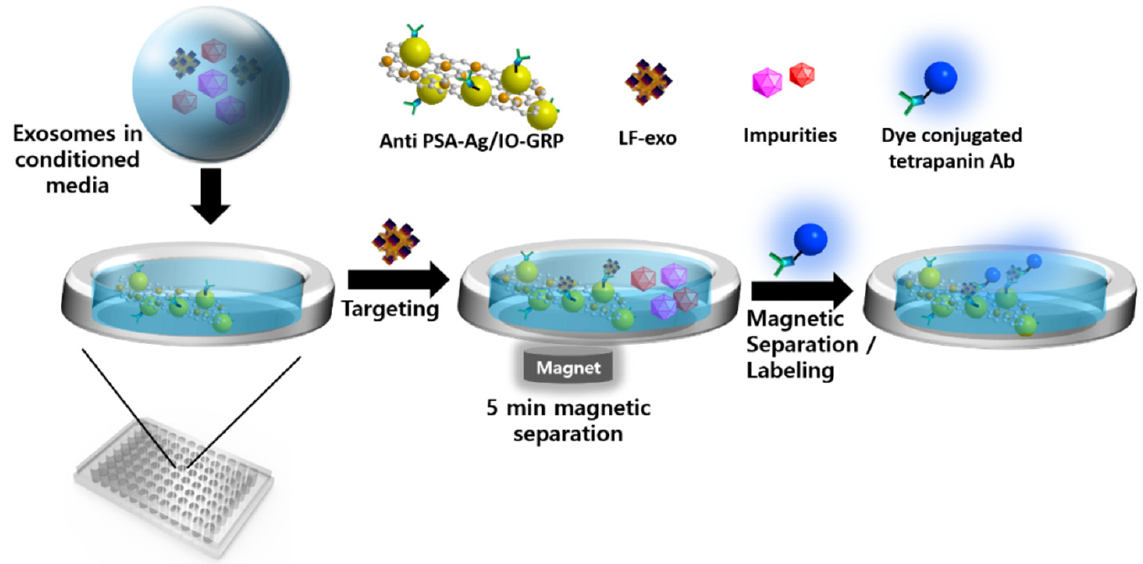
Figure 6. Schematic illustration of a Ag/IO-GRP-based MFI system for the detection of cancer-cell-derived exosomes.